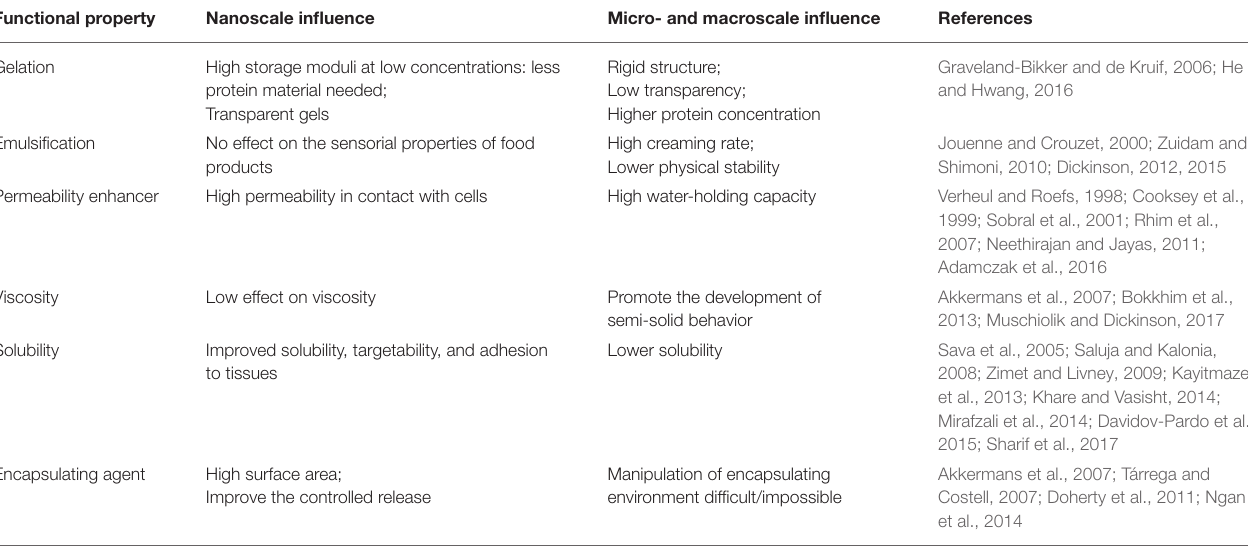
TABLE 2 | Influence of nano-, micro-, and macroscale on protein functional